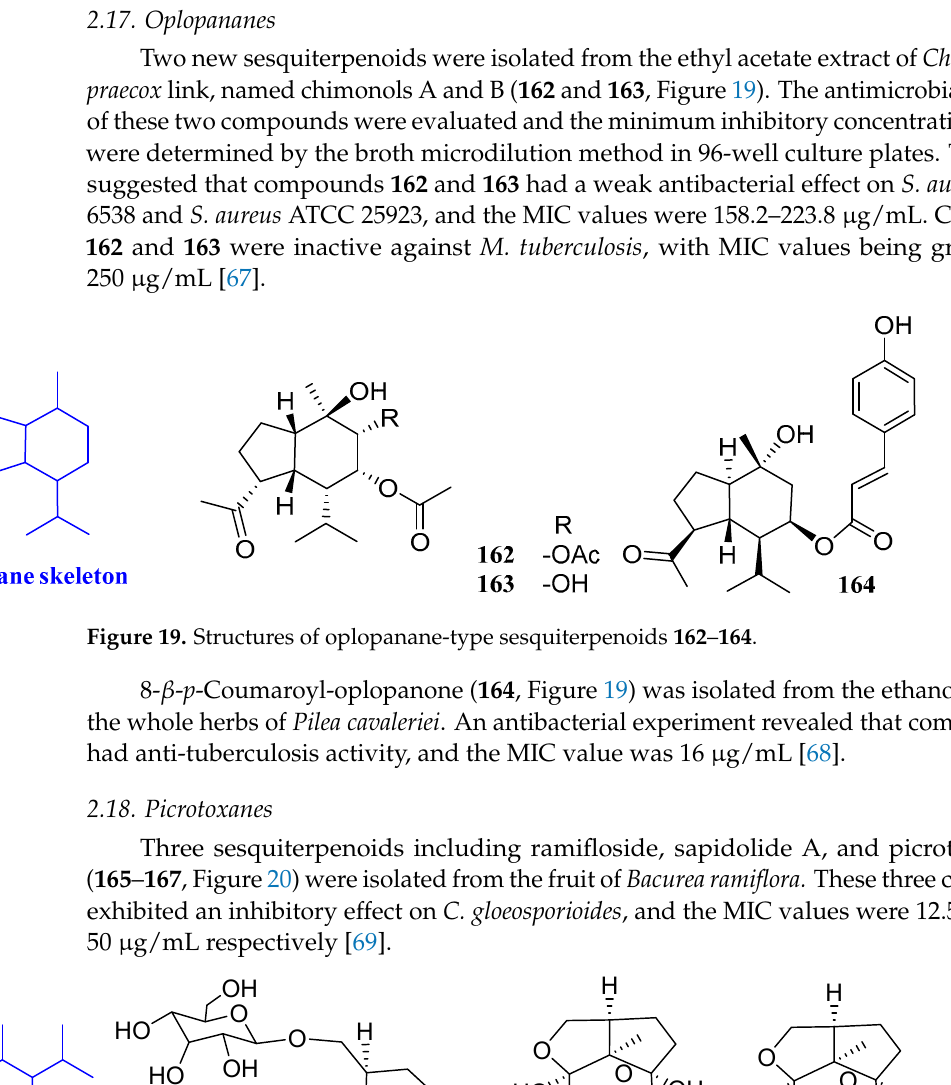
Figure 18. Structures of illudalane - type sesquiterpenoids 159 – 161 .